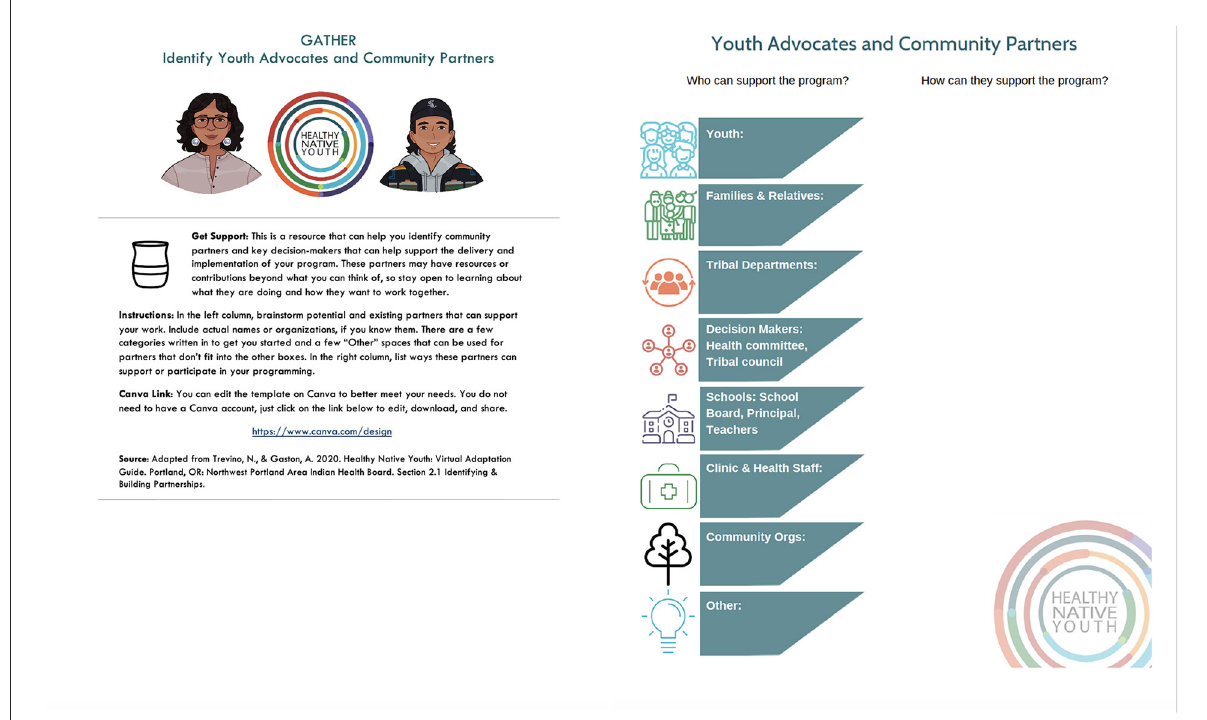
FIGURE8 Template for GATHER phase: Youth advocates and community partners map.